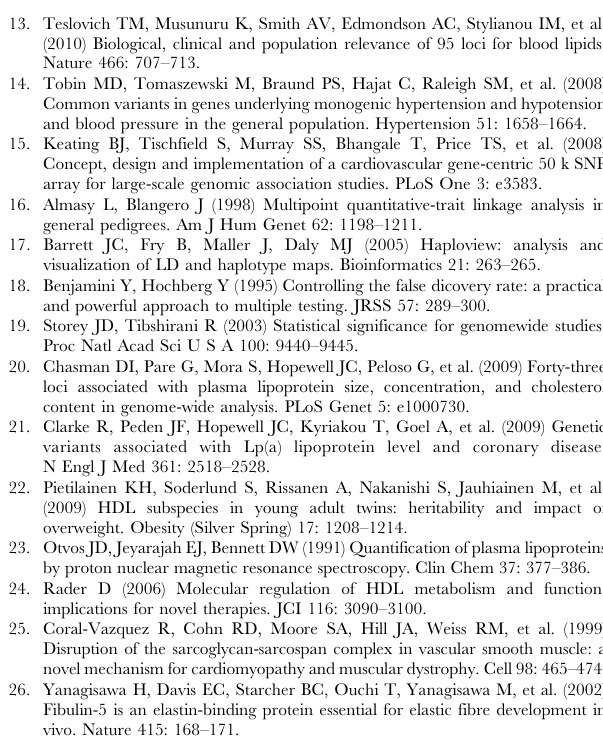
Table S3 Lead SNPs for 10 genes with the strongest association results for HDL particle number. Results are from GEE regression analyses adjusted for age, age 2 and gender. The right part of the table shows association results of the SNPs with the other two measured traits’ HDL cholesterol and mean HDL particle size.